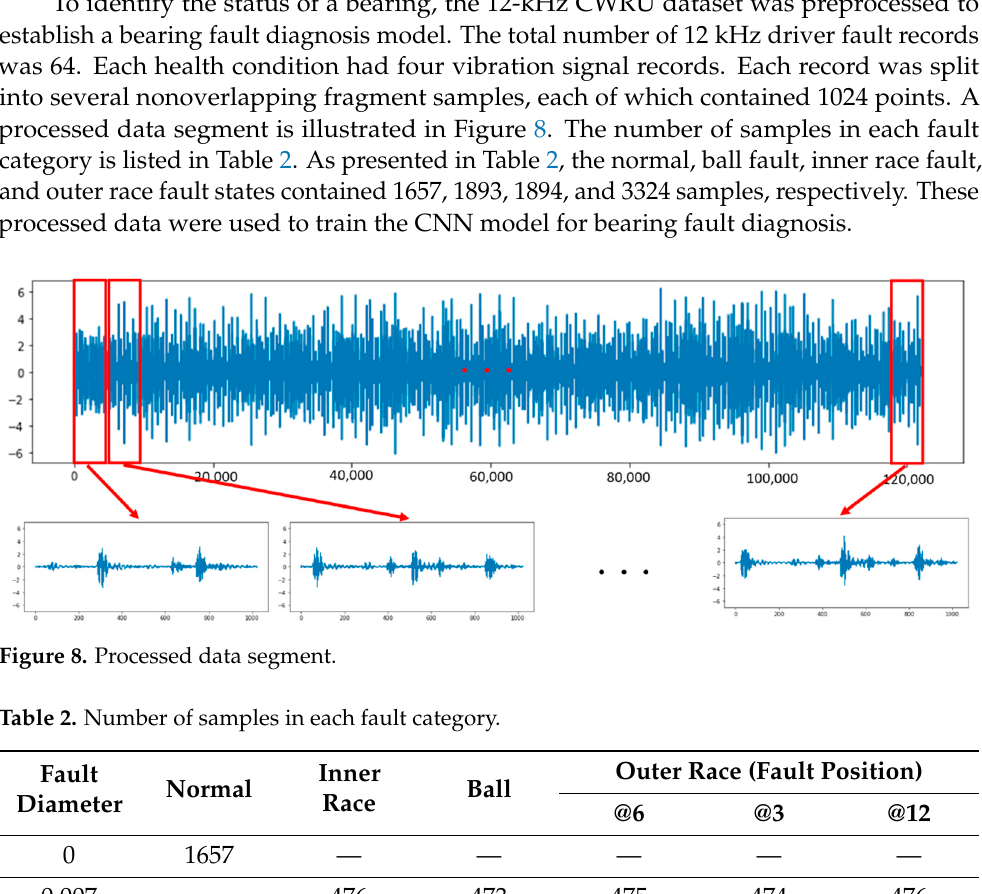
12 of 21 Table 1. Status conditions corresponding to different bearing vibration signals. Fault Diameter